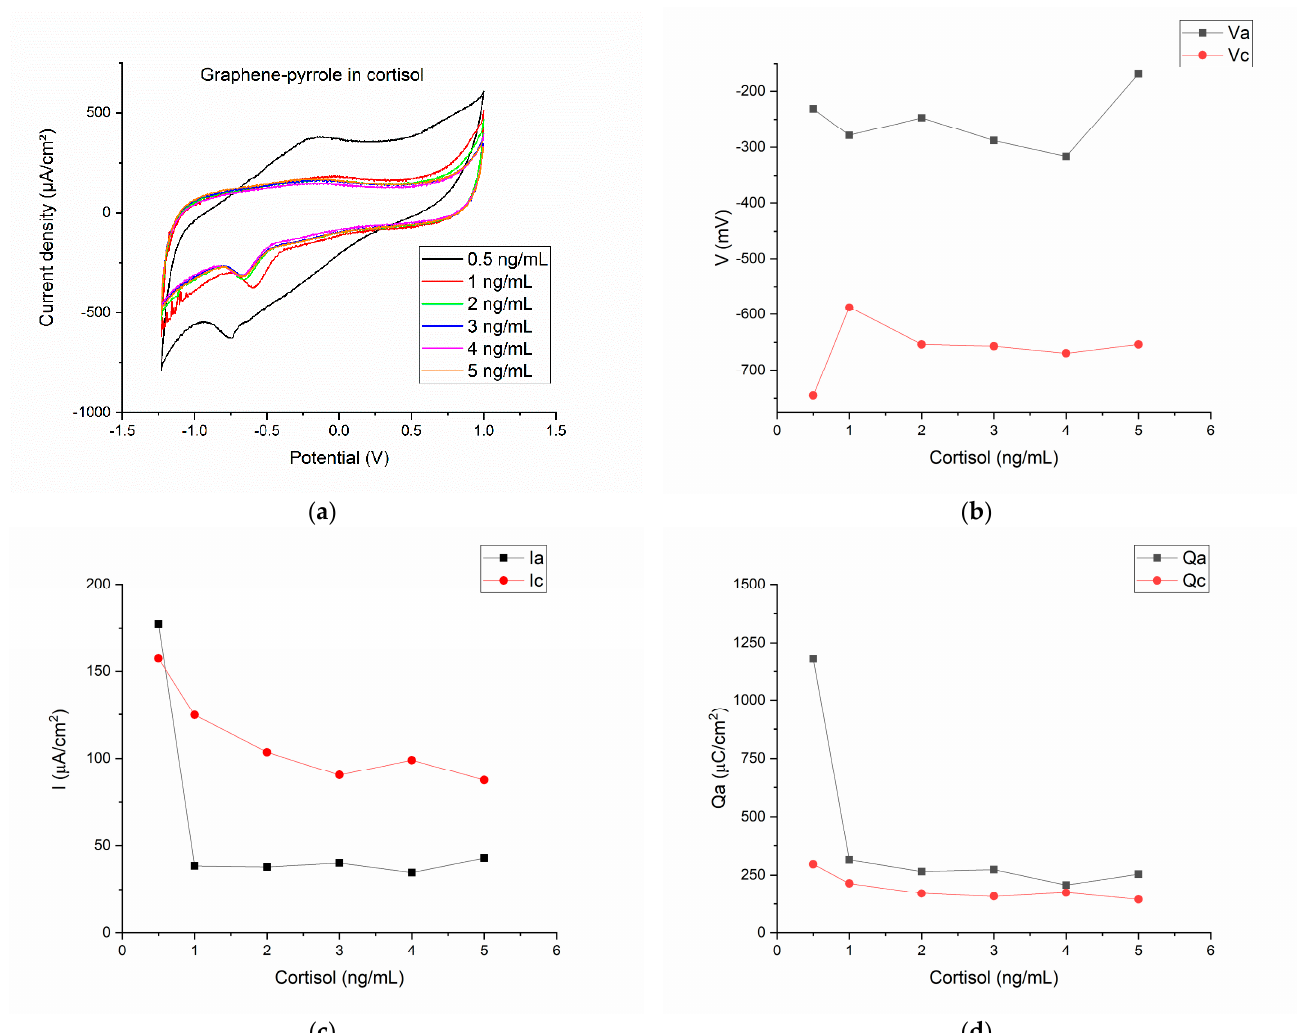
Figure 3. Electrochemical results for the detection of cortisol in artificial saliva with the composite material: ( a ) the cyclic voltammograms for the six concentrations of hydrocortisone in artificial saliva; ( b ) the variation of the anodic/cathodic potential with the concentration of the cortisol samples; ( c ) anodic/cathodic peak intensity variation as function of the cortisol concentration; ( d ) the charge transfer for the anodic/cathodic processes as function of the different cortisol concentrations.